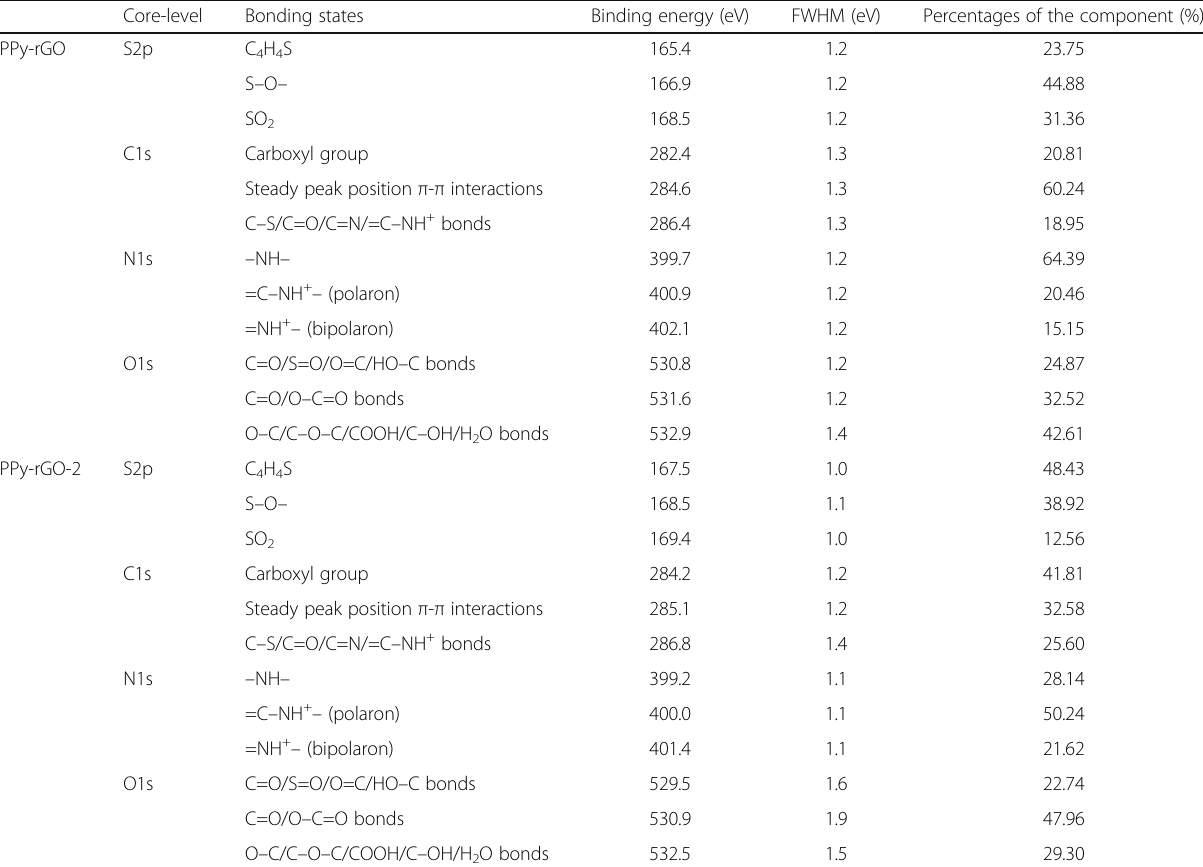
Table 2 Curve fitting results for core-level binding energies of fabricated nanocomposites